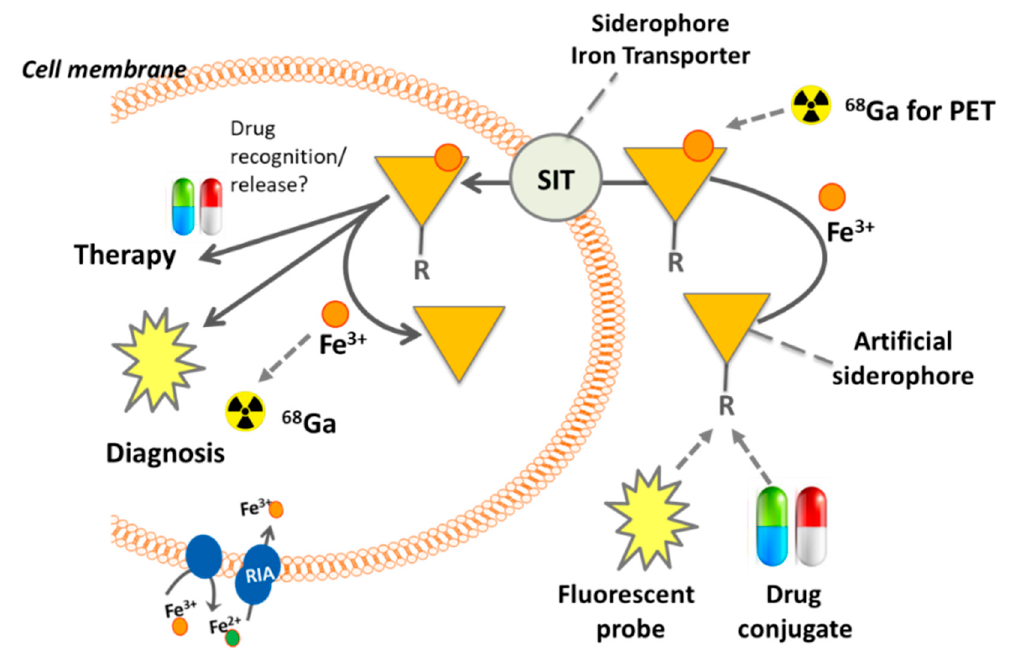
Figure 2. Concept of siderophores for medical translation including the use of natural siderophores, artificial siderophores, modified siderophores attached to fluorescent probes or drugs, and radiolabeled with gallium-68 to allow molecular imaging and/or therapeutic applications. The uptake by siderophores mediates intracellular uptake potentially enabling diagnosis via radioactive or fluorescent signaling or therapy by the introduction of antifungal drugs, thereby following a Trojan horse approach. The dotted line arrows mark replacement of iron by gallium-68 (for PET) or conjugation of fluorescent probes or drug moieties to siderophores (artificial siderophores). The solid line arrows mark the metabolic route and translational goals of siderophores.